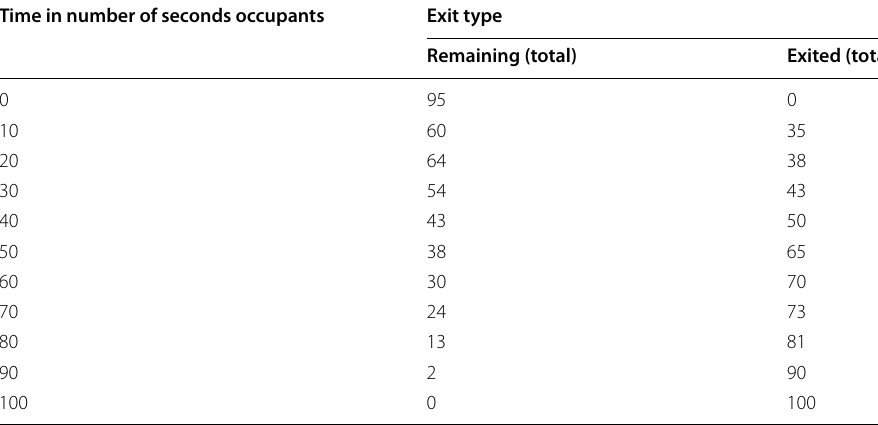
Table 1 Evacuation of personnel in each room and exit